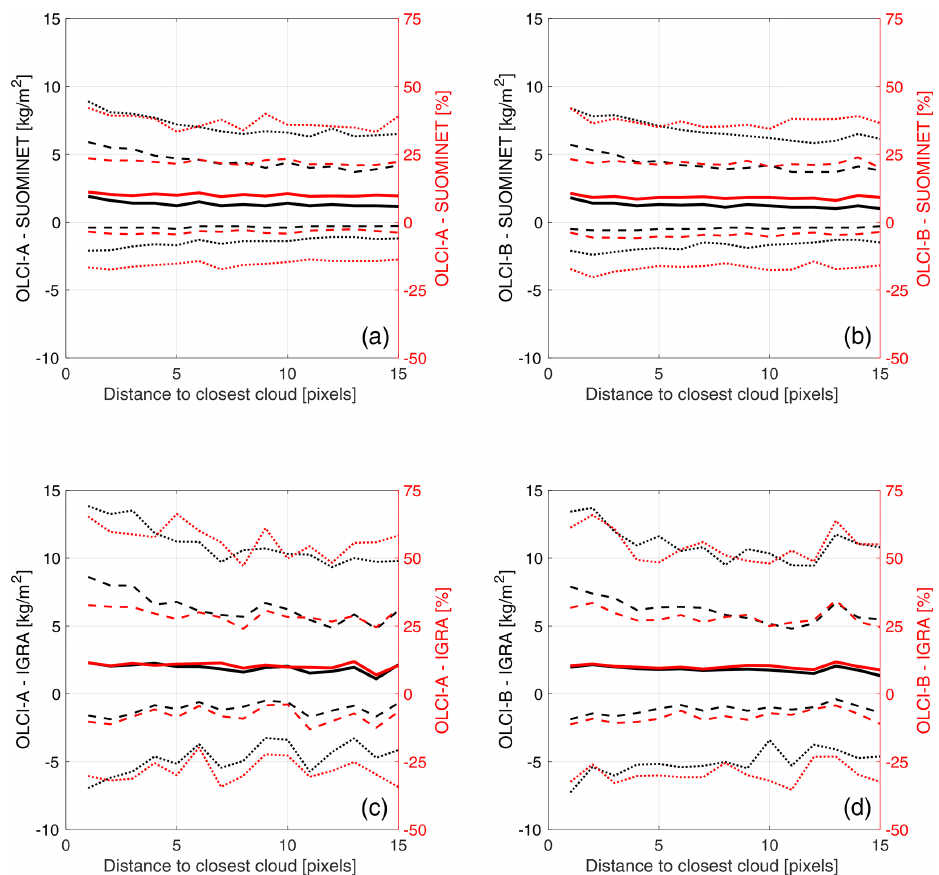
Figure A1. Dependency of observed OLCI difference against SuomiNet (a, b) and IGRA (c, d) observations to distance to closest cloud- flagged pixel for OLCI-A (a, c) and OLCI-B (b, d) . Black lines show the difference in kgm − 2 , while the red lines show the relative difference in percent. The solid line shows the median of each 2kgm − 2 wide bin, while the dashed lines show the 16th and 84th percentiles and the dotted lines the 5th and 95th